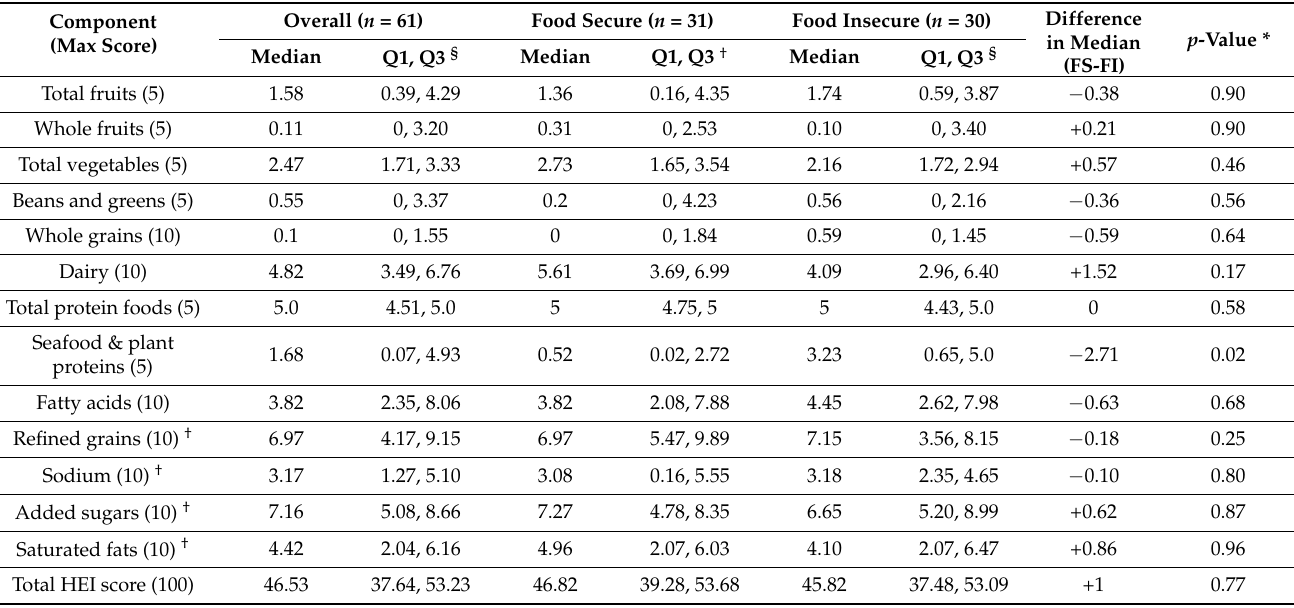
Table 2. Median Healthy Eating Index 2015 component and total scores, expressed as absolute scores for adolescents ages 14 to 19 years with food security or food insecurity living in Baltimore City ( n =